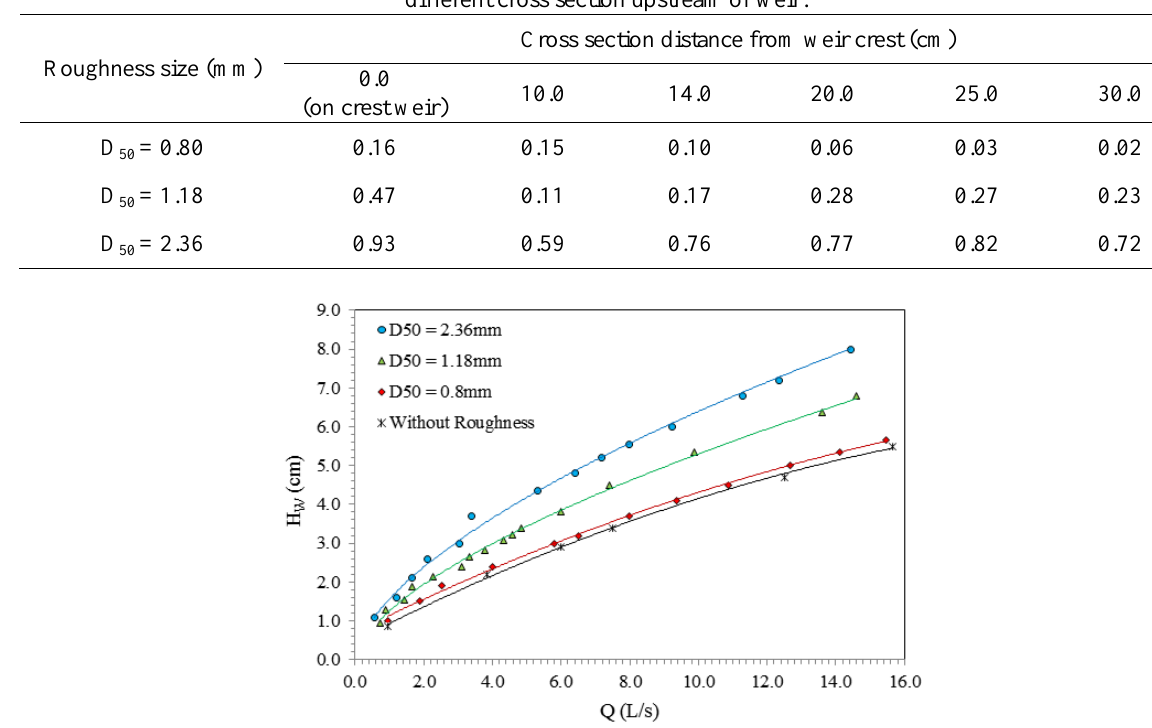
Fig. 5. - Stage-Discharge relation on weir for different roughness